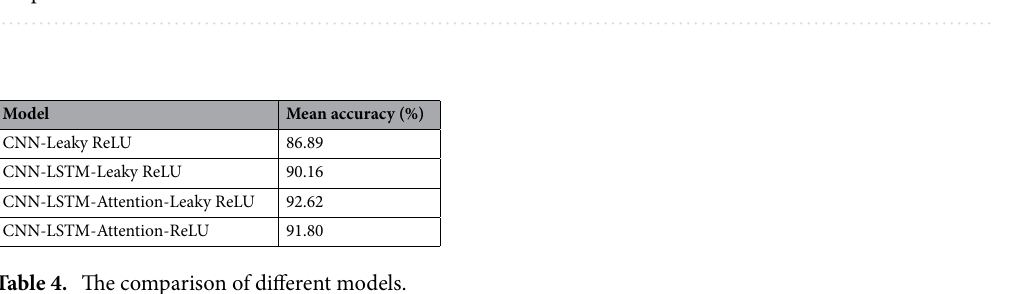
Table 4. The comparison of different